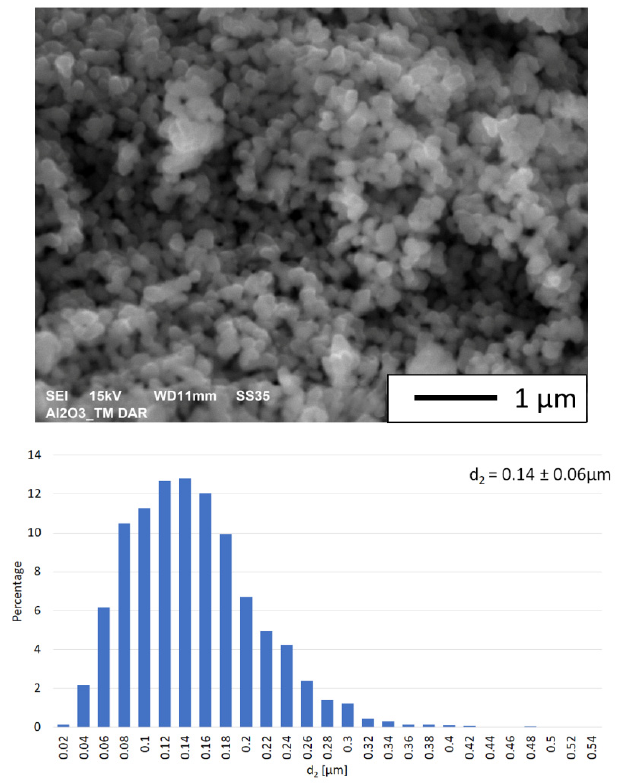
Figure 1. Microstructure and histogram of the particle size distribution of alumina powder.